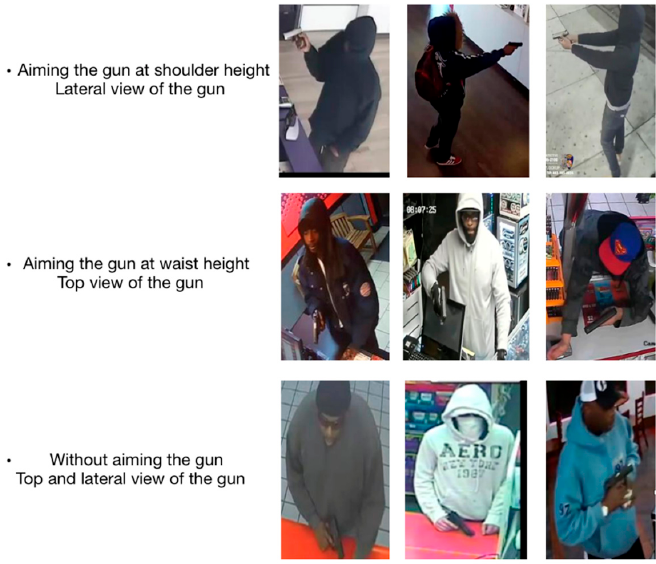
Figure 3. Firearm position.